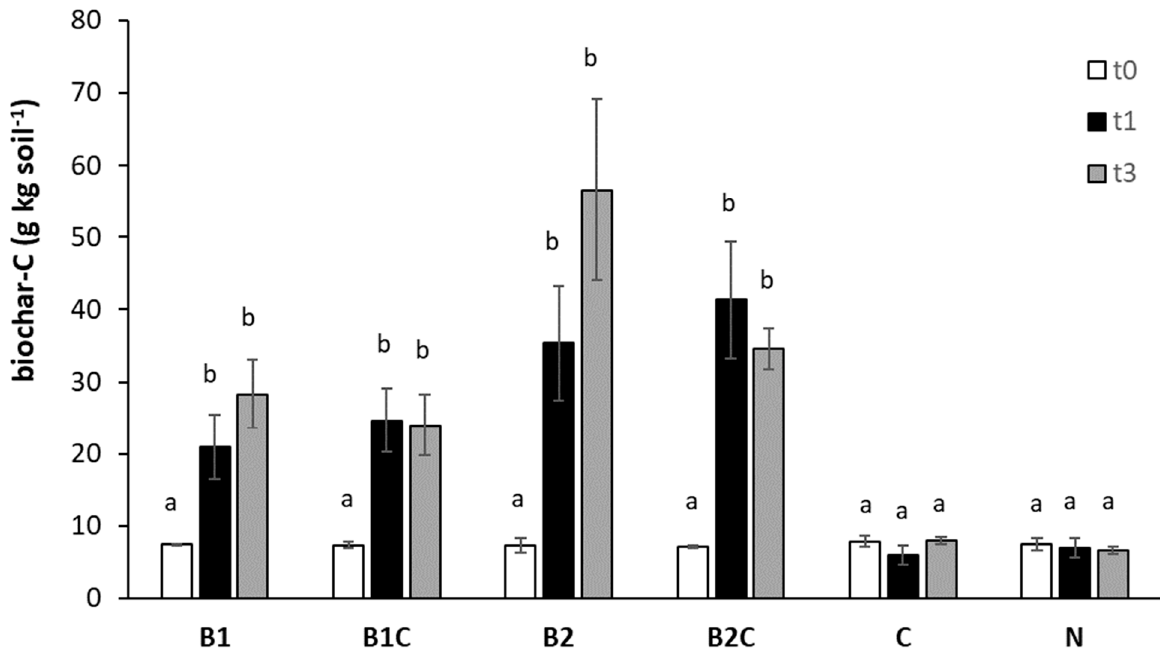
Figure 2. Biochar-C content in the soil (g kg − 1 ) according to BPCA analysis in the six experimental treatments: N (control), B1 (25 t ha − 1 biochar), B2 (50 t ha − 1 biochar), C (45 t ha − 1 compost), B1C (25 t ha − 1 biochar + 45 t ha − 1 compost), B2C (50 t ha − 1 biochar + 45 t ha − 1 compost) before the distribution of soil amendments (white bars, t0), 3 weeks later (black bars, t1) and 2 years later (gray bars, t3). Different letters above the bars indicate statistically significant differences between the sampling times within the same treatment ( p ≤ 0.05). Vertical bars represent the standard error of the mean.